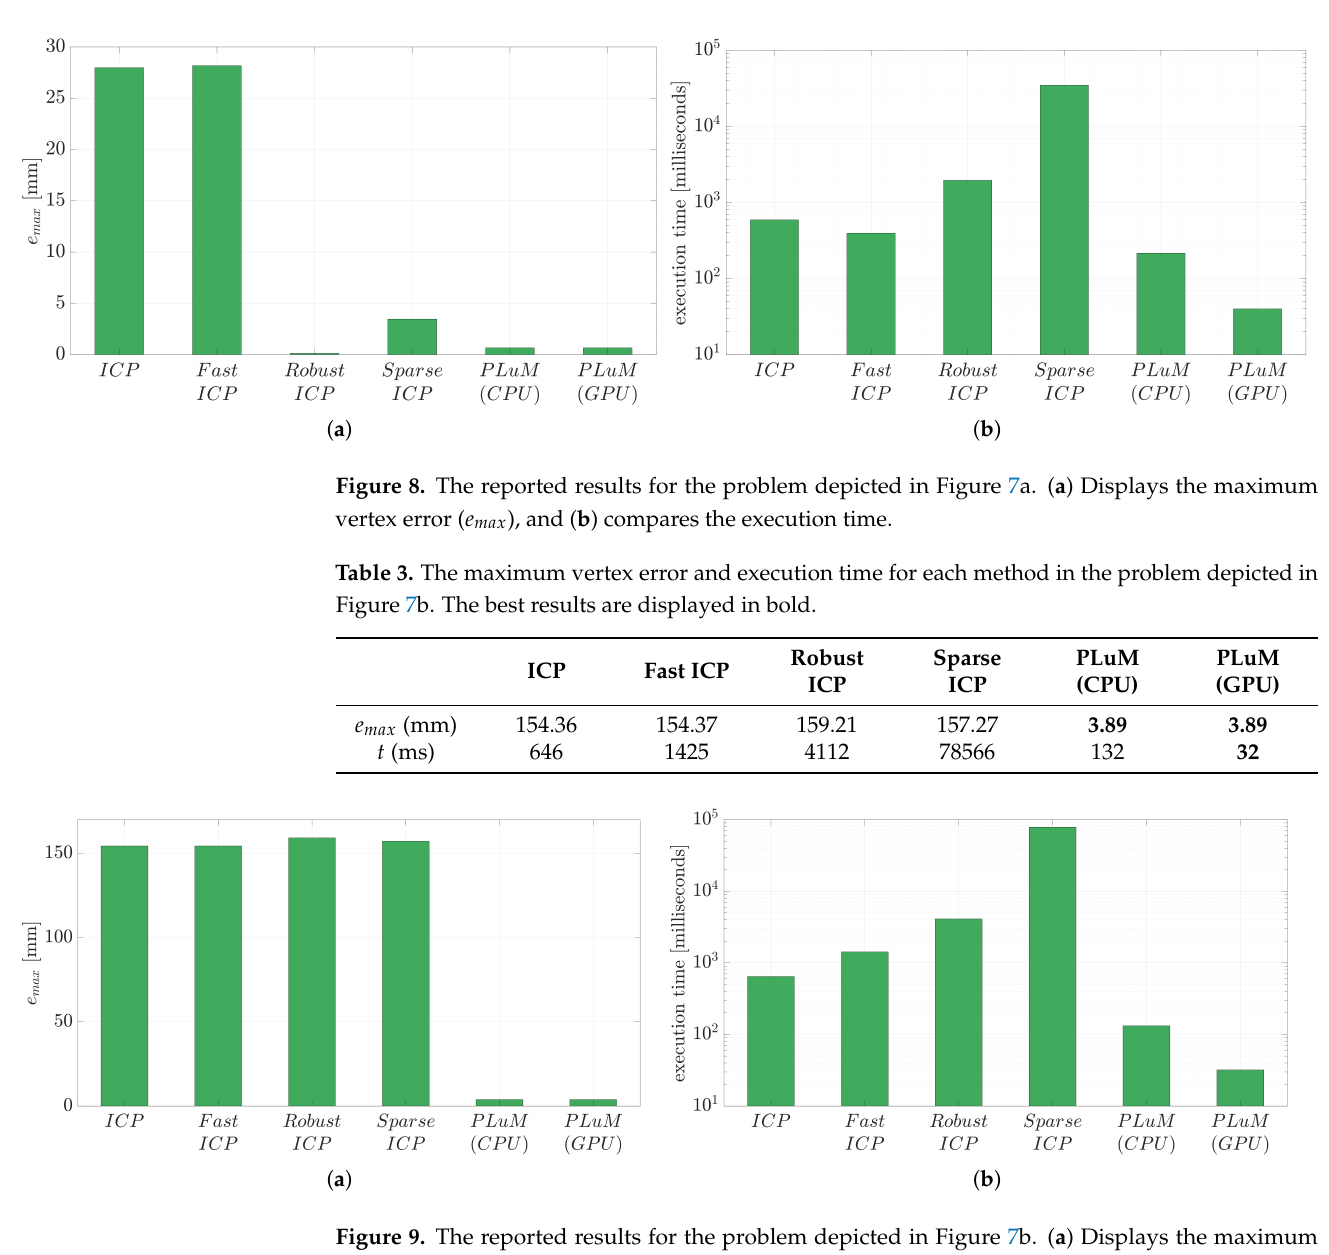
Figure 9. The reported results for the problem depicted in Figure 7b. ( a ) Displays the maximum vertex error ( e max ), and ( b ) compares the execution